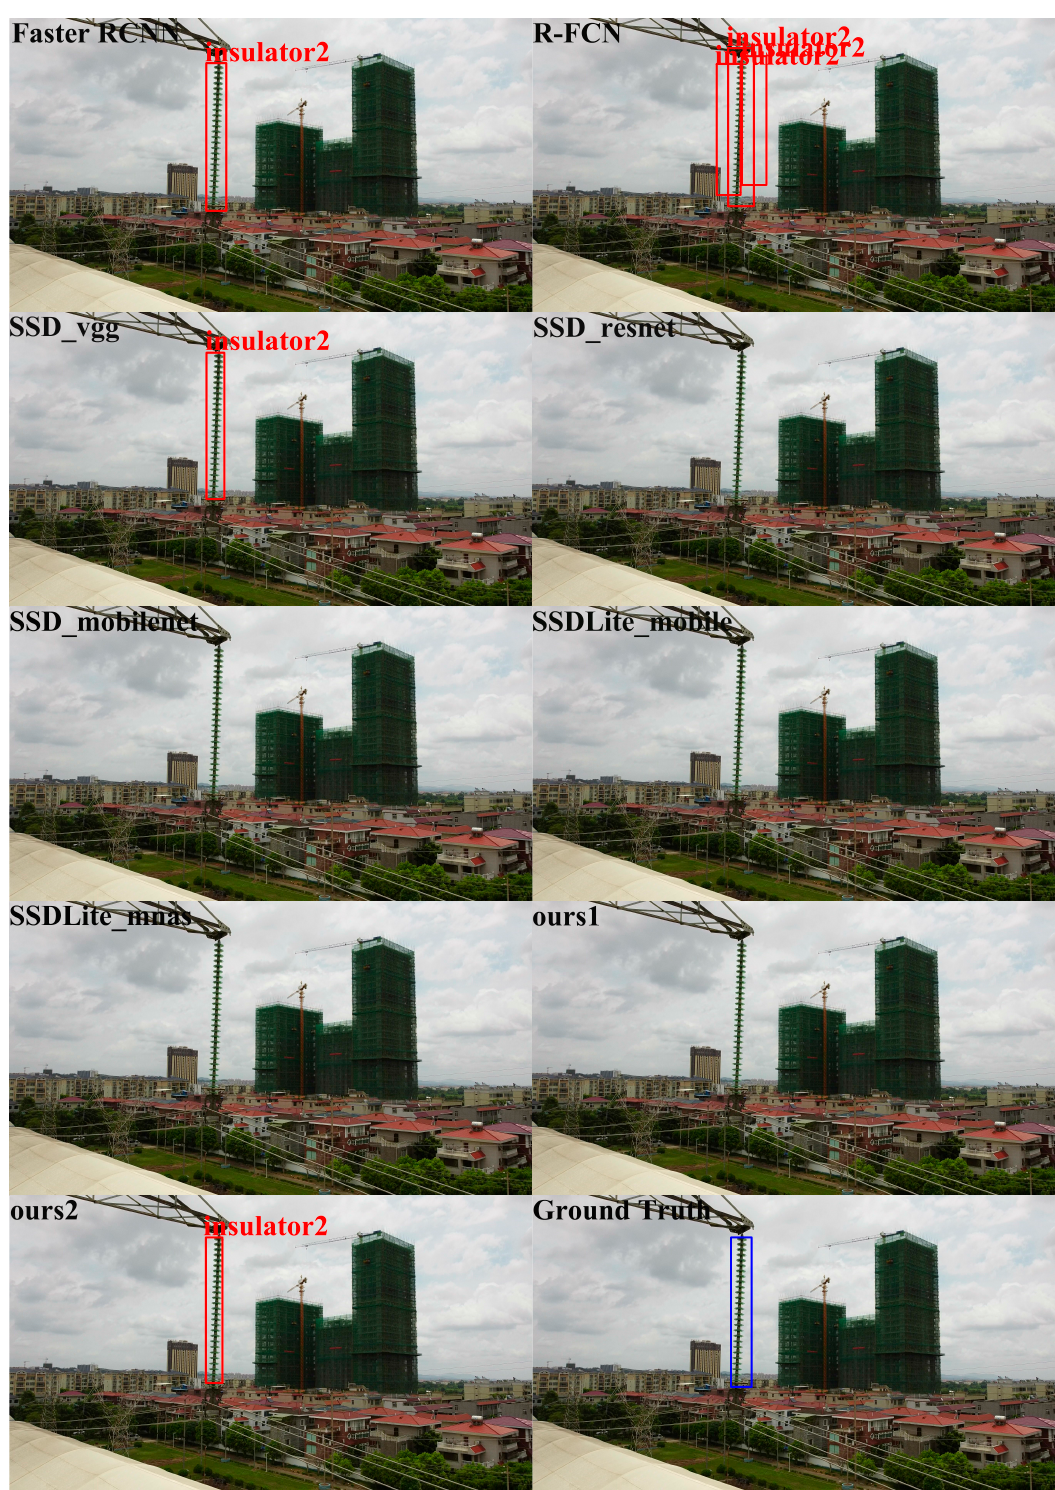
Figure 10. Insulator2 detection results. The blue box is the ground truth of the position of insulator2 in the image.